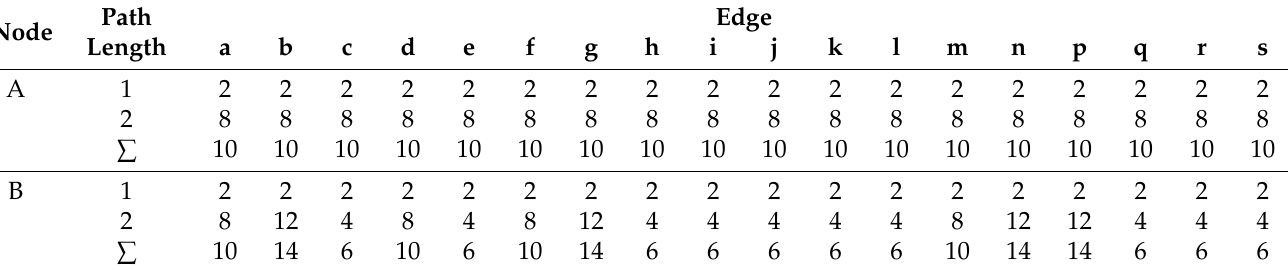
Table 2. Distribution of the use of edges in the analyzed